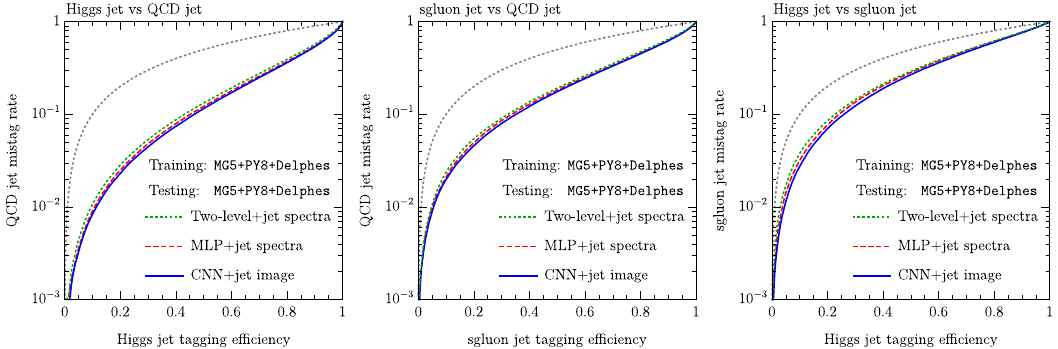
Figure 10 . The ROC curves of the binary classi(cid:12)ers: the MLP trained on S 2 ; trim and S 2 ; soft (red dashed), the CNN trained on jet images (blue solid), and the two-level architecture (see section 4) trained on S 2 ; trim and S 2 ; soft (green dotted) with PY8 samples. The dashed gray lines represent the ROC curves of the random guess. We show the results of Higgs jet vs. QCD jet (left), sgluon jet vs. QCD jet (center), and Higgs jet vs. sgluon jet (right) classi(cid:12)cations. ~y = (0 ; 1) for the background. The QCD jet mistag rates are comparable for both